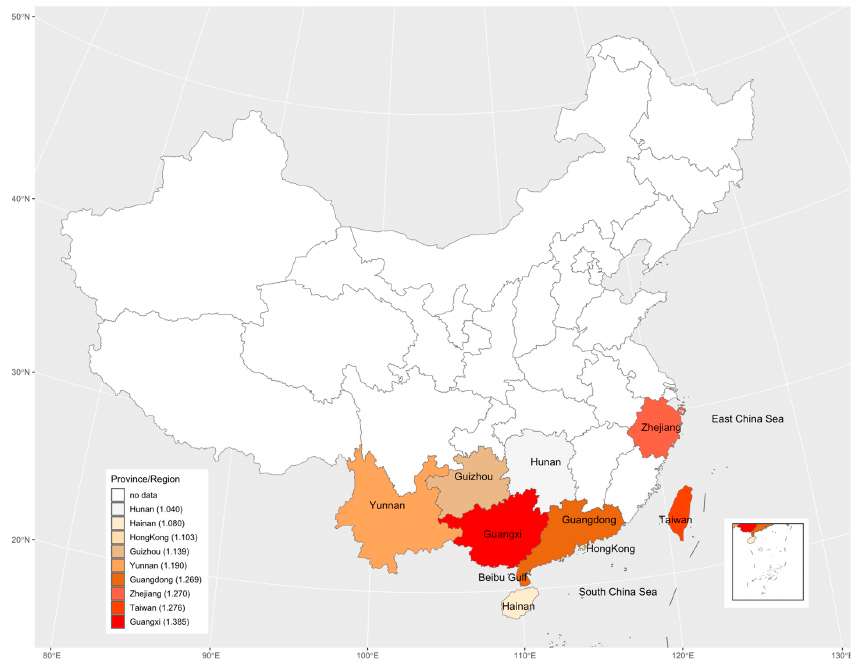
Figure 7. The geographic distribution of the basic reproduction number across the nine study areas. The legend indicates that from top to bottom, the darker the color is, the greater the basic reproduction number is. The numbers in legend brackets are the average of the basic reproduction numbers for each province/region.